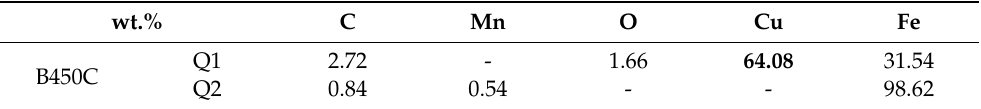
Figure 6. SEM images of carbon steel B450C surface, after removal of the layer formed during the exposure for 30 days to SS1 cement extract solution: ( a ) ×500 and ( b ) magnification ×3000 of the highlighted zone in ( a ). Table 10. EDS surface analysis (wt.%) of B450C after the removal of the corrosion layer formed during exposure for 30 days to SS1 cement extract solution.